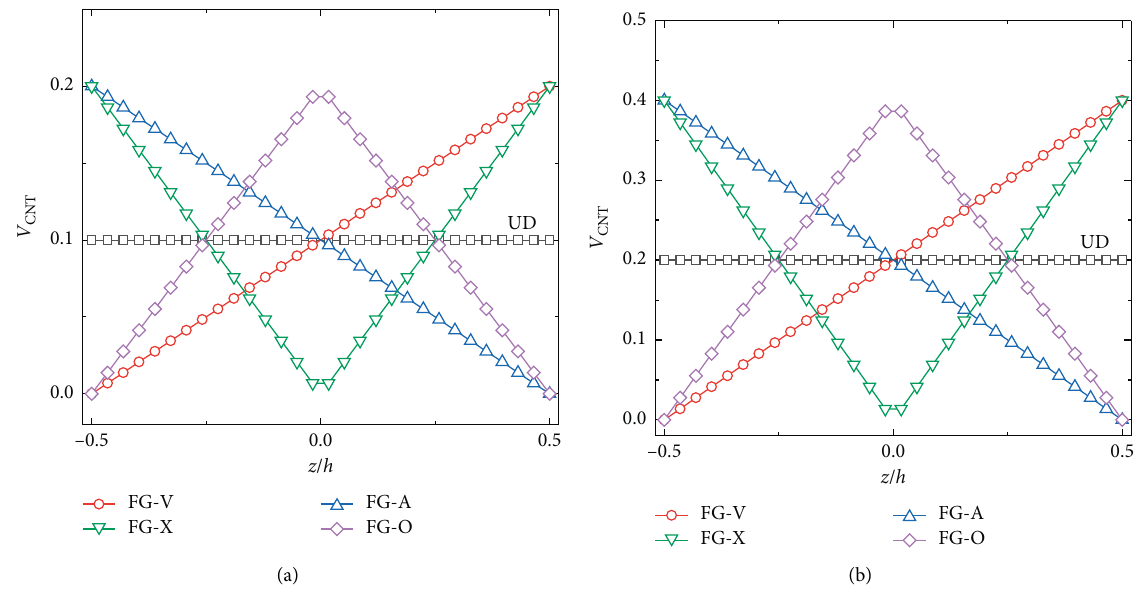
Figure 3: Change of the CNT volume fractions V